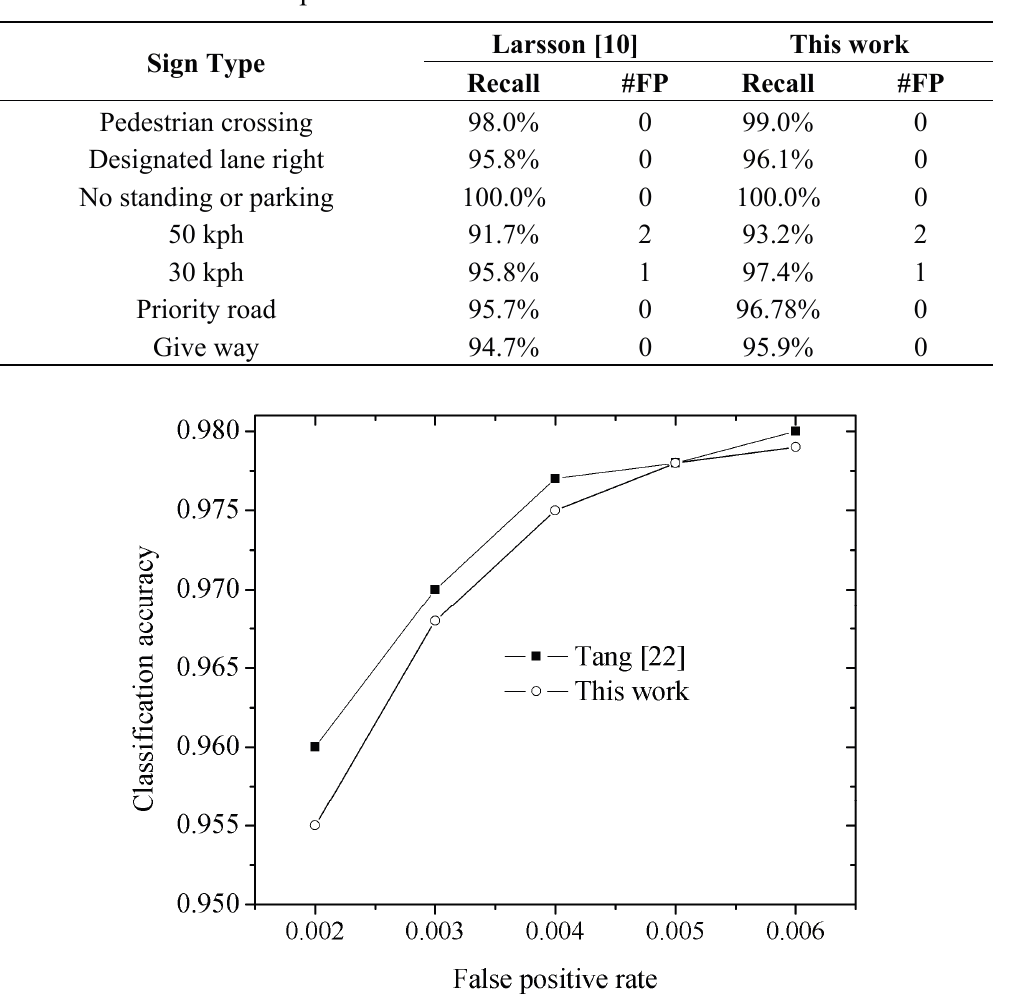
Table 9. Comparison with other works for the STS data set.